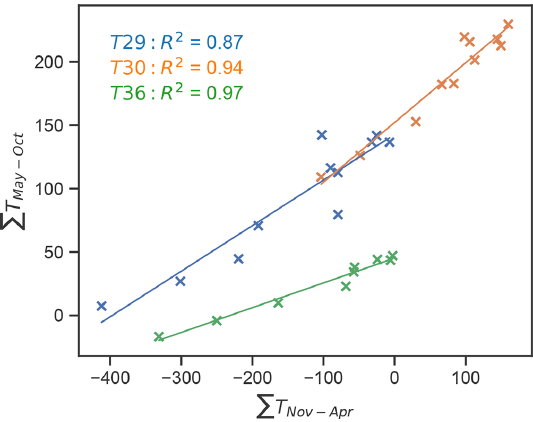
Figure 5. Cumulative temperature for the accumulation period (November–April) vs. the following ablation period (May–October) for each of the three main monitoring sites inside the cave (T29, T30 and T36); data points are accompanied by a regression